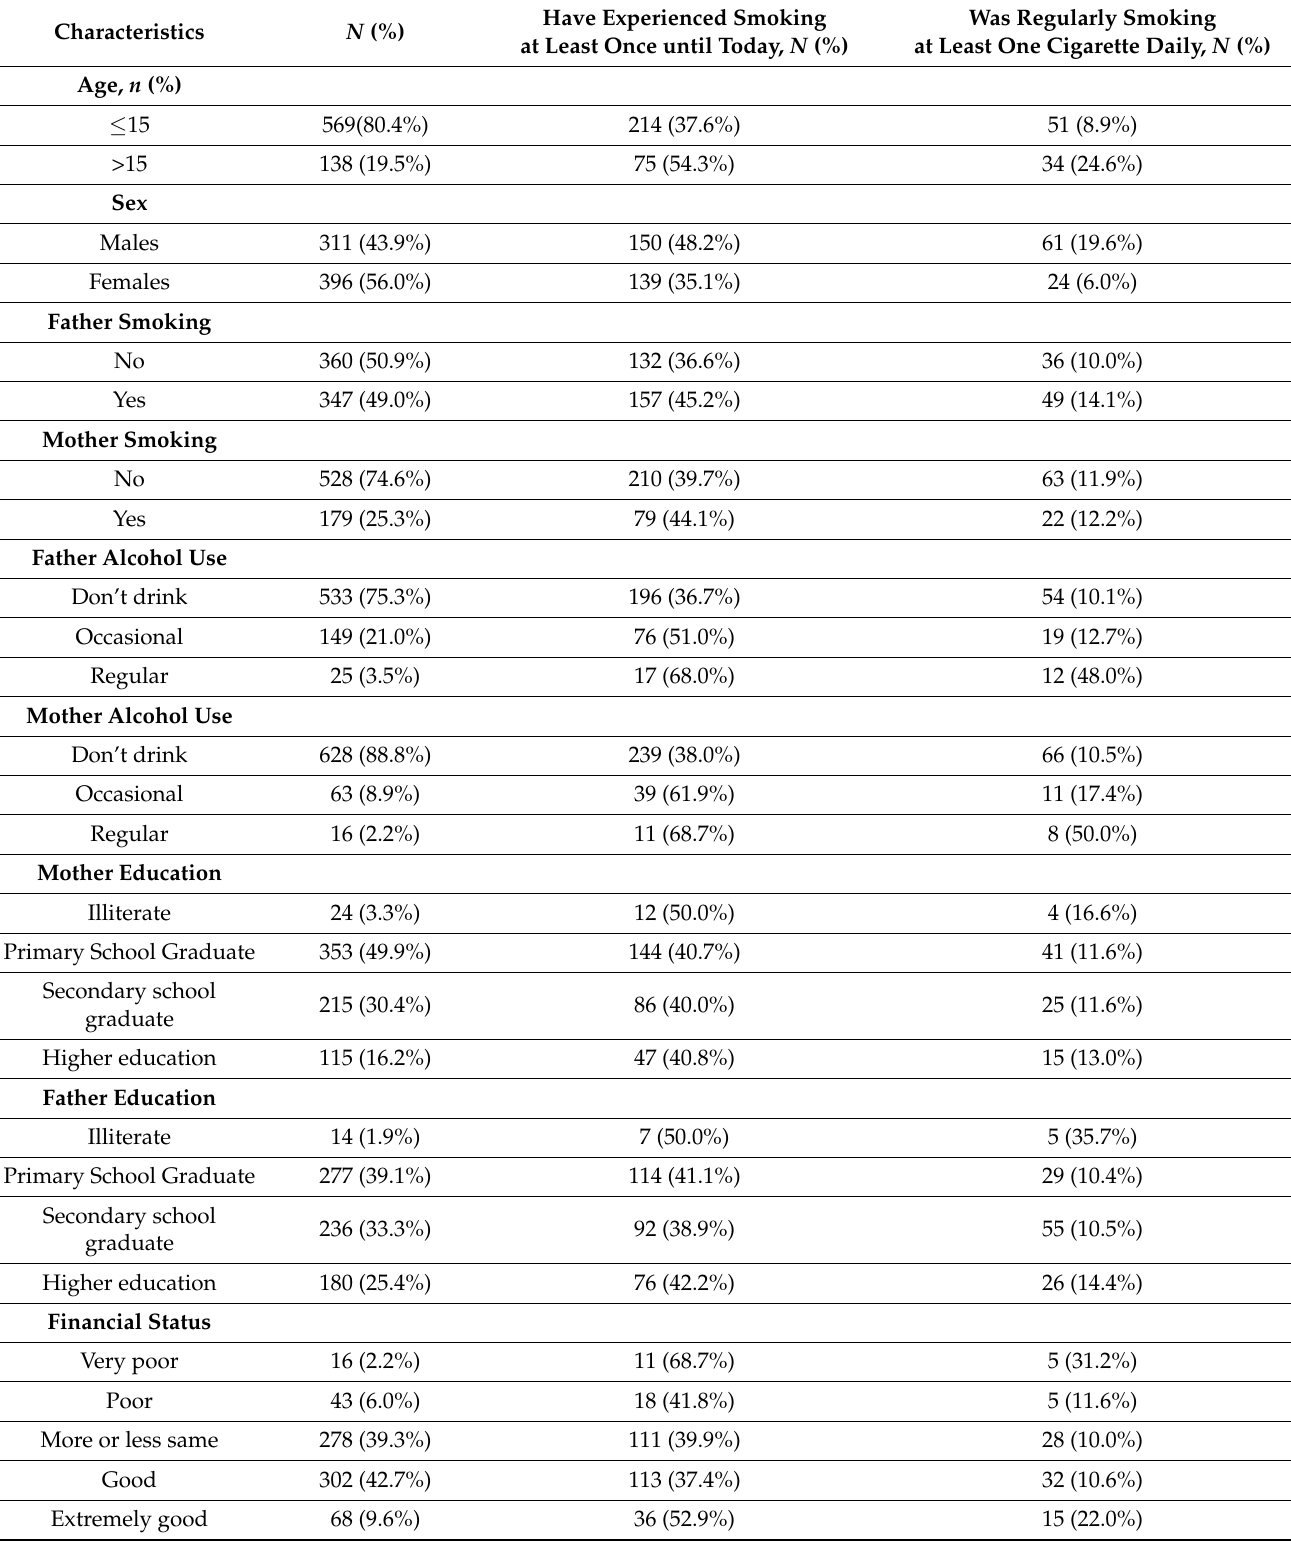
Table 1. Parental, family and student characteristics according to smoking behaviour of the students.